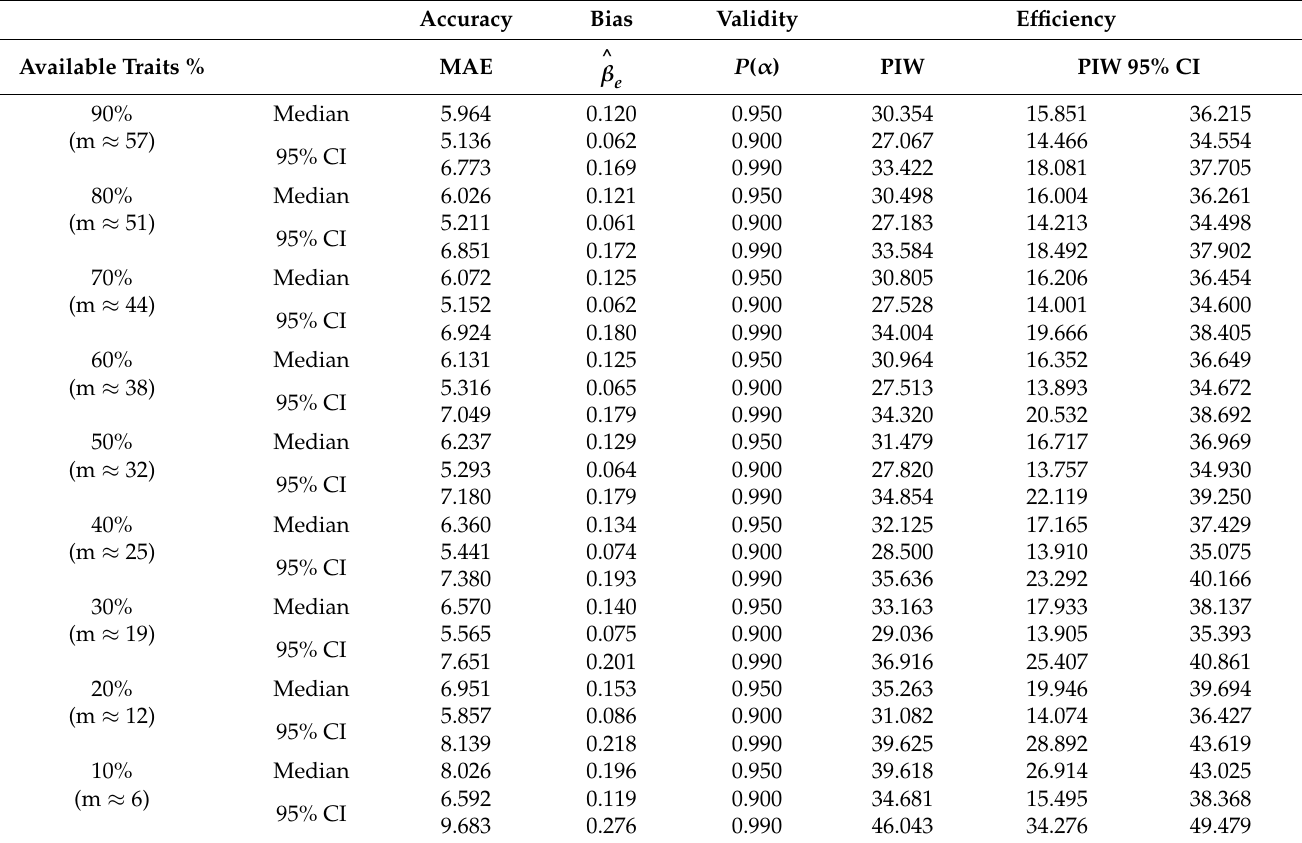
Table 4. Monte Carlo cross-validation metrics for DRNN models built on different fractions of available skeletal